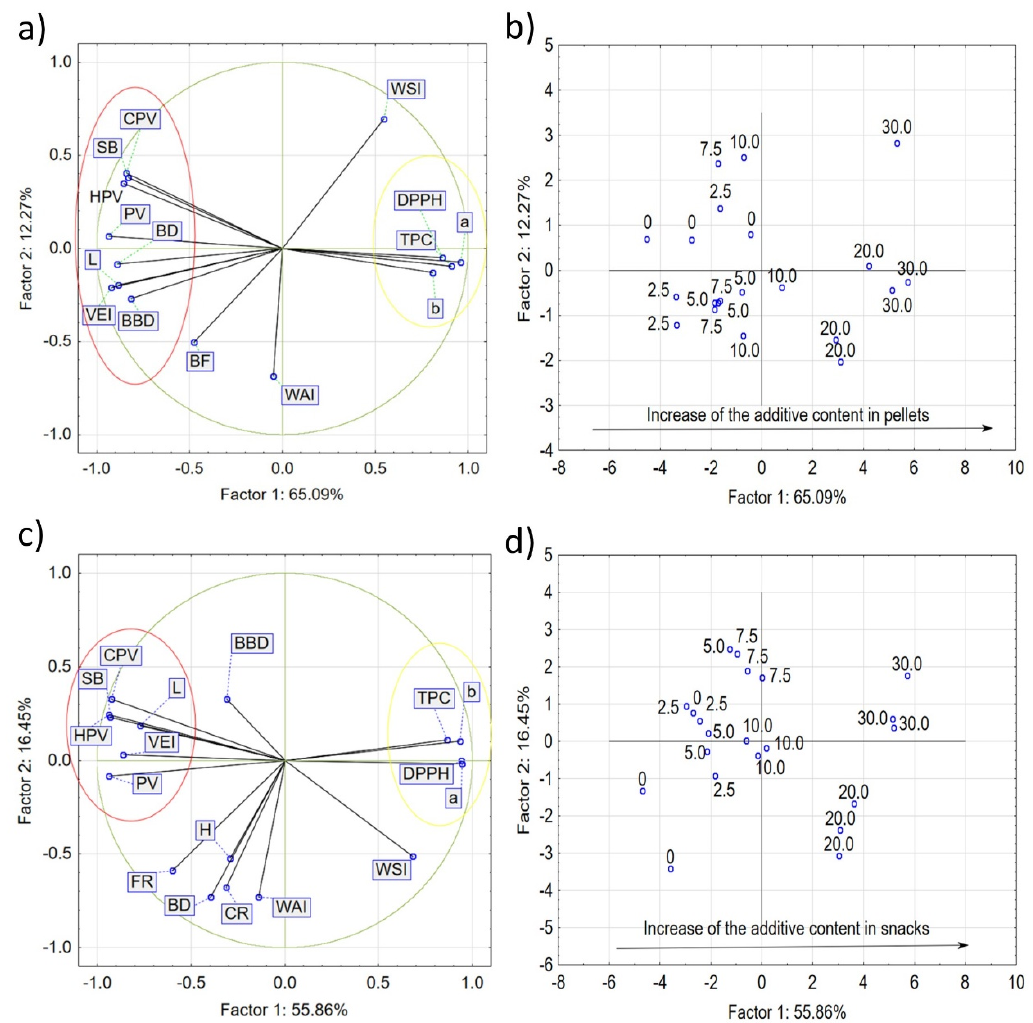
Figure 6. Analysis of principal components (PCA) of pellet ( a ) and snack ( c ) features and objects, as well as pellets ( b ) and snacks ( d ) in the space of the first two major components: TPC—total phenolic content; DPPH—antioxidant activity; BBD—bulk density; EI—volumetric expansion index; WAI—water absorption index; WSI—water solubility index; L *- lightness; a *—balance between redness (+) and greenness (-); b *—balance between blueness (-) and yellowness (+); PV—peak viscosity; HPV—hot paste viscosity; CPV—cold paste viscosity; BD—breakdown; SB—setback; CF—cutting force; H—hardness; CR—crispness; FR—fracturability; Factor 1—first component; Factor 2—second component; 0–30—amount of fresh carrot pulp (g/100 g).